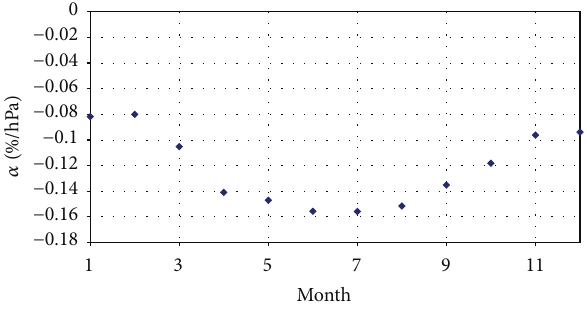
Figure 5: It is the same as Figure 4 but for Adelaide muon